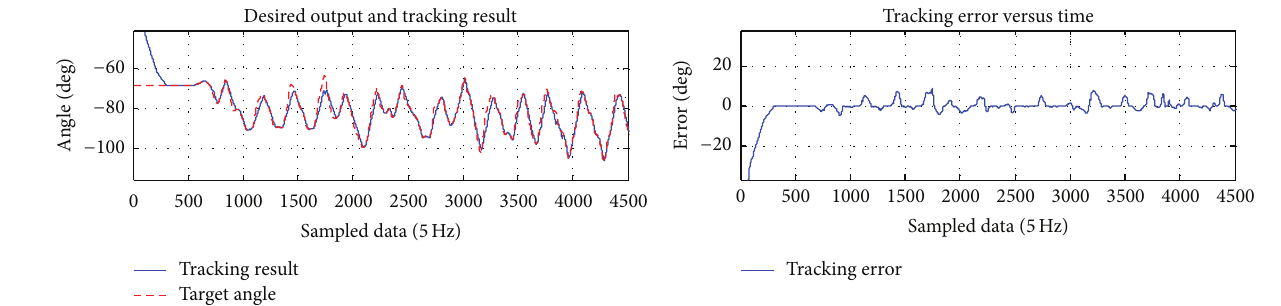
Figure 10: Tracking error of random set fuzzy surface with proposed